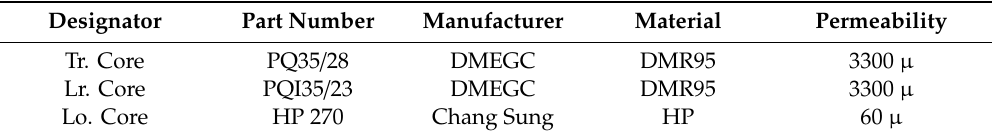
Table 9. Magnetic core selection in optimized